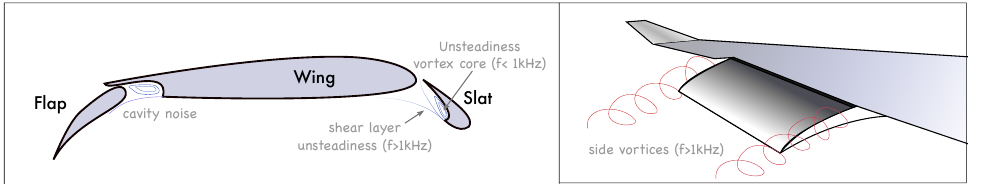
Figure 2. Slat and flap noise of an